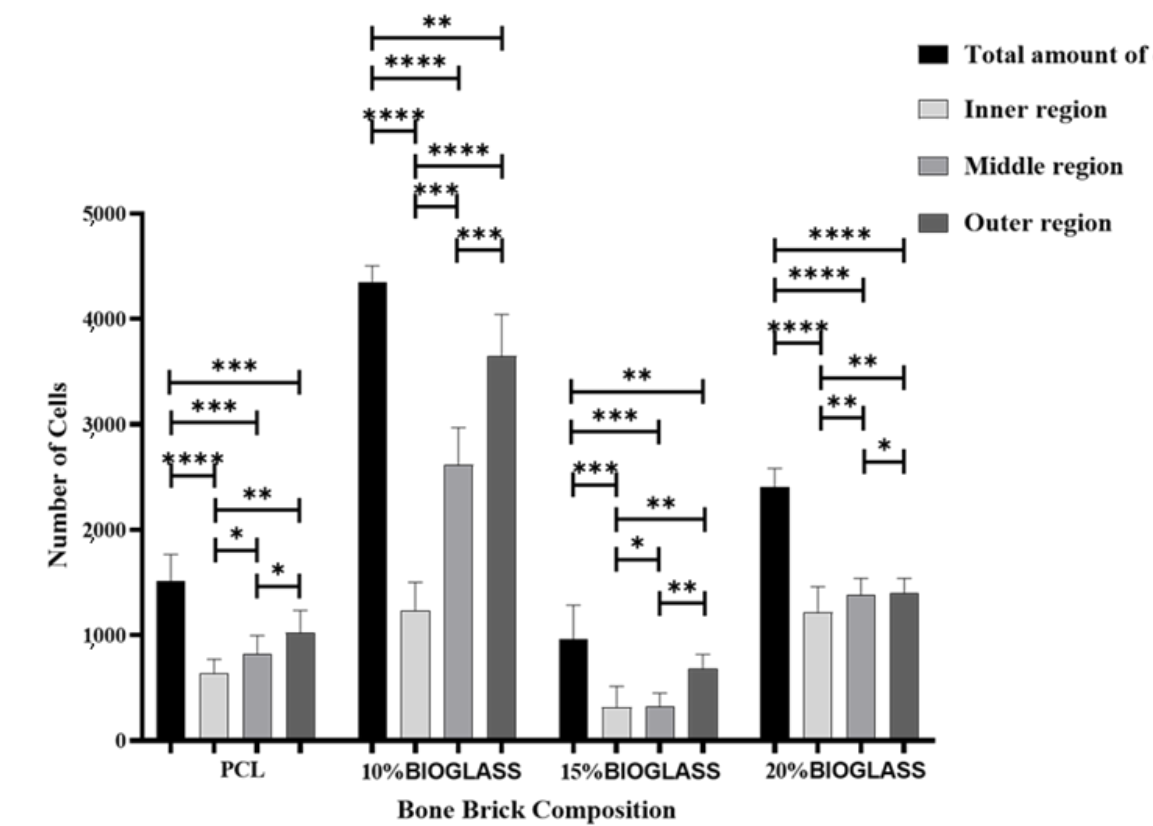
Figure 14. The cell count at day 14 after cell seeding in different regions of the scaffolds. *